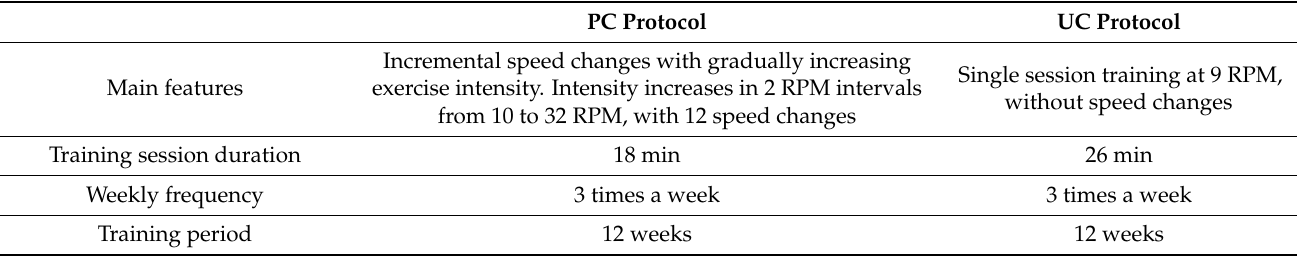
Table 1. A schematic description of the two different aerobic exercise protocols used to train